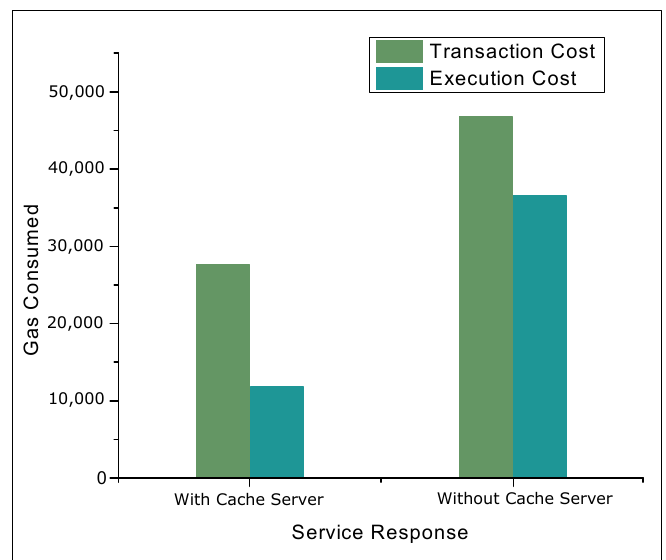
Figure 9. Performance of System with and without Cache Server.